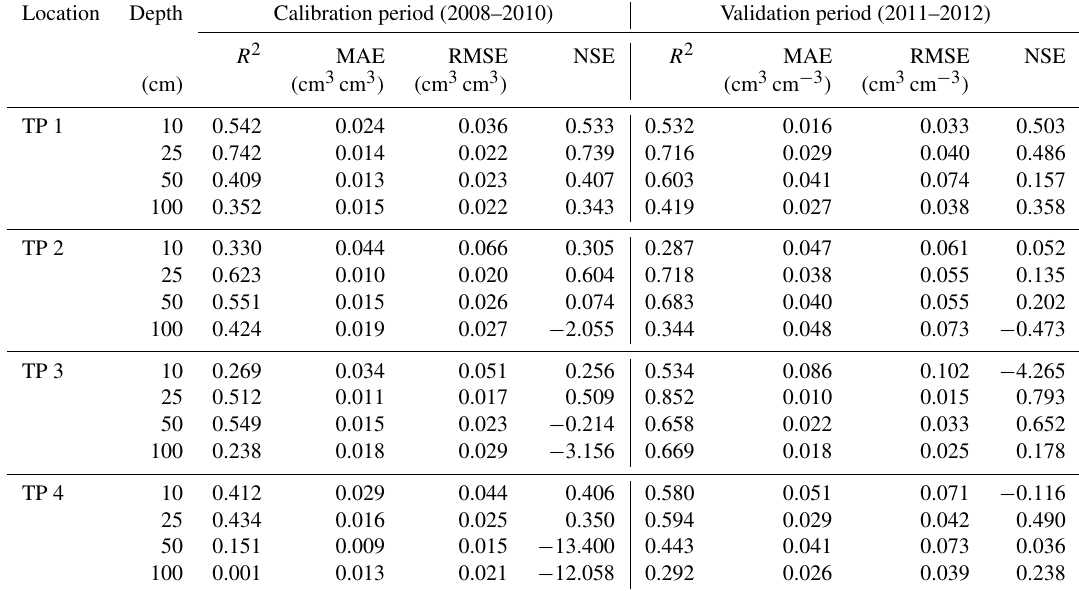
Table 3. Goodness-of-fit measures for simulated and observed SWC data at different depths during the calibration period (2008–2010) and validation period (2011–2012) at TP locations. Note that we assume a good fit as an RMSE between 0 and 0.03cm 3 cm − 3 and fair as between 0.03 and 0.06cm 3 cm − 3